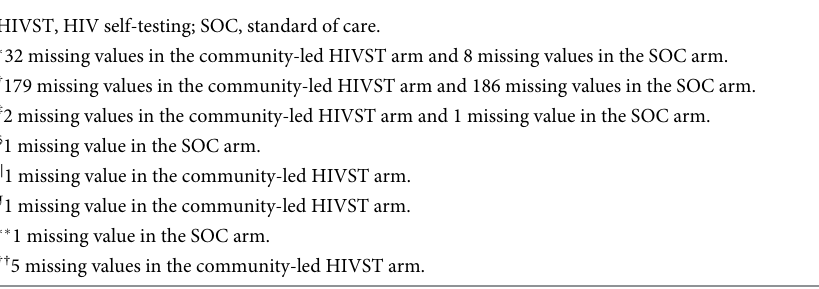
Table 1. Comparison of population characteristics by study arm. Household